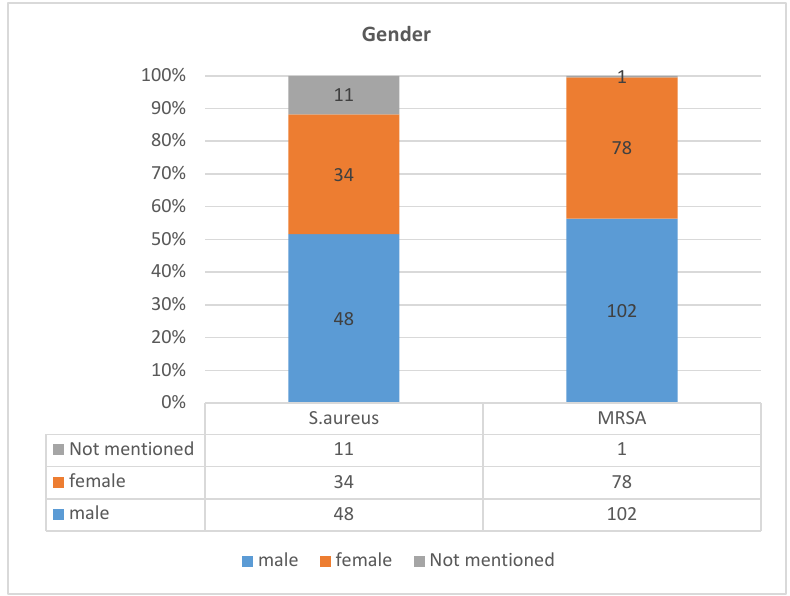
Table 4. Patterns of Staphylococcus aureus lineage infections across different age-groups in Ha’il region, Saudi Arabia.